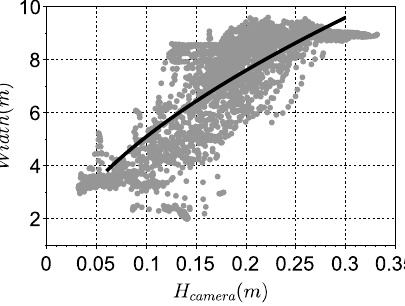
Figure 14. The water surface width as a function of the water height. The stage is taken from the camera data set. The flow width is taken from the width detection and Eq. (2). The trend line equa- tion is W = 19 . 19 H 0 . 58 camera .